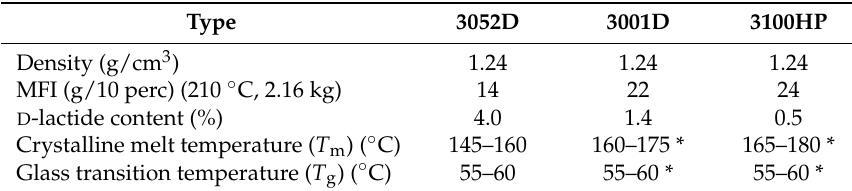
Table 1. Properties of the selected polylactic acid (PLA)